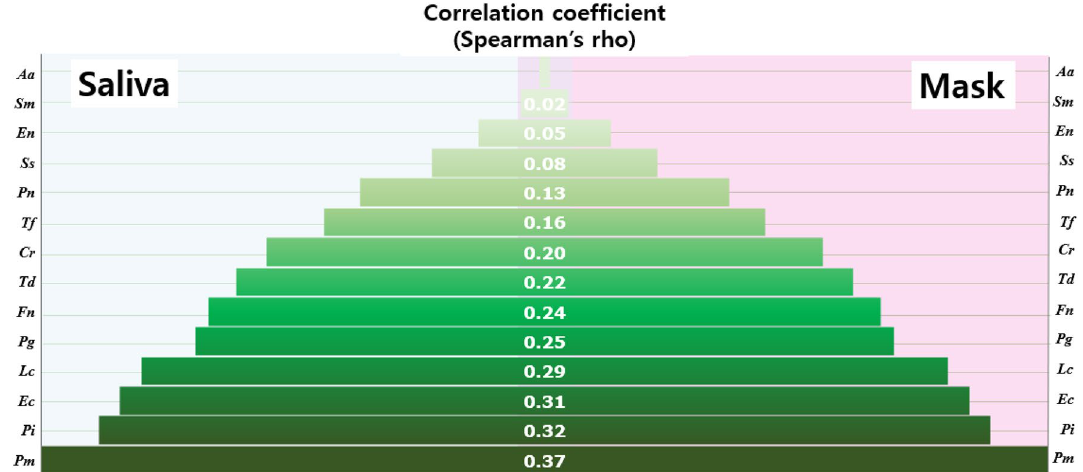
Figure 5. Arrangement in increasing order of correlation between bacteria in saliva and the inner surface of the mask. Aa: Aggregatibacter actinomycetemcomitans; Sm, Streptococcus mutans; En, Eubacterium nodatum; Ss, Streptococcus sobrinus; Pn, Prevotella nigrescens; Tf, Tannerella forsythia; Cr, Campylobacter rectus; Td, Treponema denticola; Fn, Fusobacterium nucleatum; Pg, Porphyromonas gingivalis; Lc, Lactobacillus casei; Ec, Eikenella corrodens; Pi, Prevotella intermedia; Pm, Parvimonas